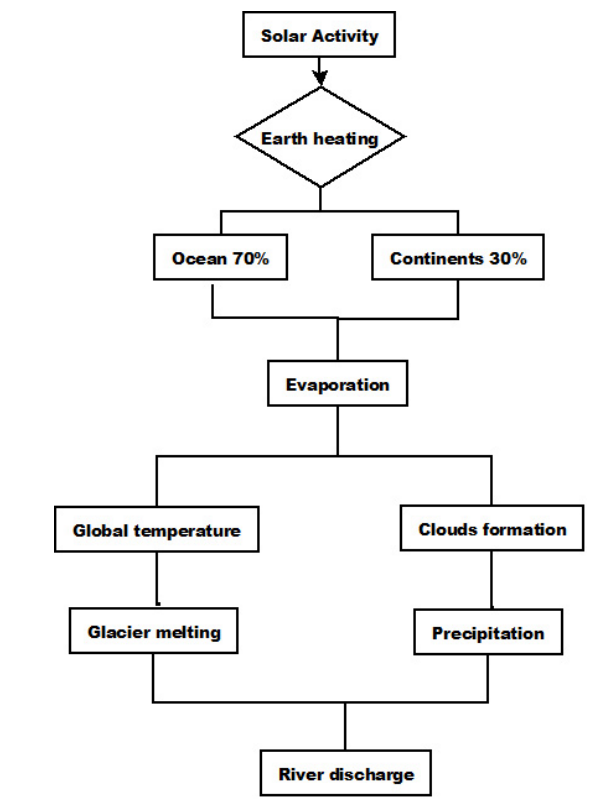
Figure 1. Scheme of river runoff formation.